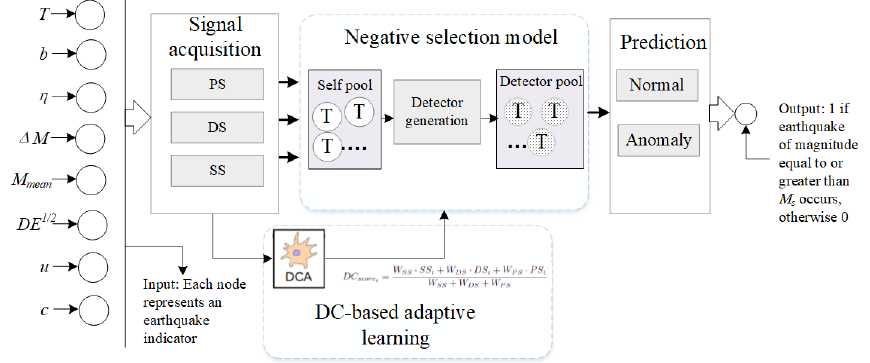
Figure 1. The DC-NSA architecture for